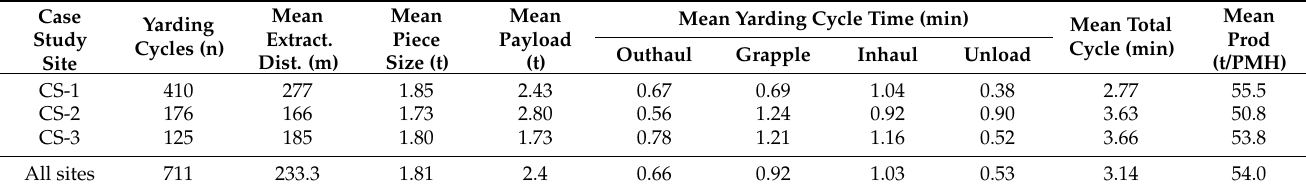
Table 1. Mean yarding information for all three-case study sites, as well as the weighted averages for all